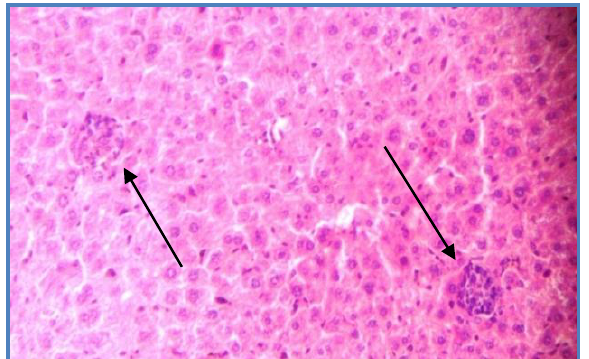
Figure, 6: Liver of mice at 10 days post infection by Candida albicans ( ) shows microabscesses in the liver parenchyma (Heamatoxcyline and Eosin stain 40X).